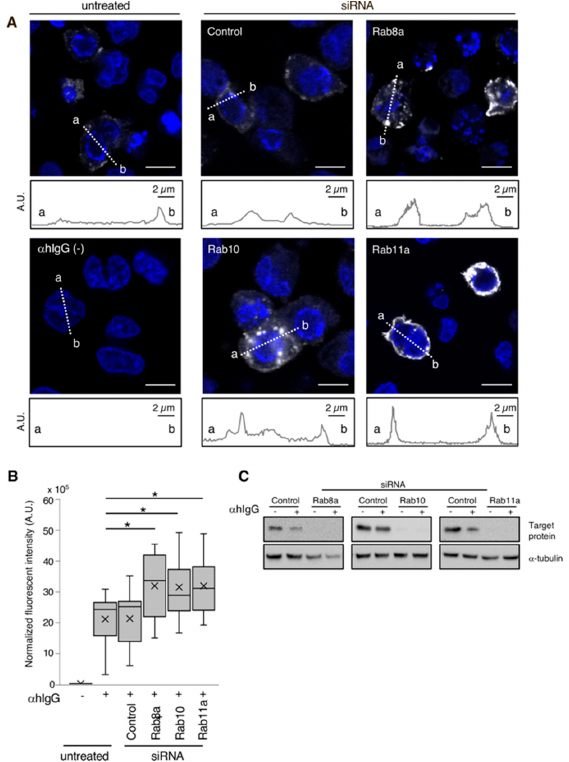
Figure 2. The effect of Rab GTPase downregulation in EBV glycoprotein distribution. Rab8a, Rab10 and Rab11a were downregulated in Akata + cells using siRNAs. After 48 h of treatment with α hIgG for the EBV lytic cycle induction, the distribution of EBV glycoprotein gp350 / 220 was analyzed by immunofluorescence staining. ( A ) Images of gp350 / 220-specific signals (white) are shown. As a control, the images of the siRNA-untreated cells with (top left) or without (bottom left) the lytic cycle induction are shown. Cell nuclei were counterstained with Hoechst 33342 and appear in blue. Plots indicate the fluorescence intensity along each of the corresponding lines. A.U., arbitrary unit. Scale bars: 10 µ m. ( B ) Summary of gp350 / 220 expression. Boxplots represent the fluorescent intensities from gp350 / 220-positive cells in four independent randomly selected fields. Results are representative of three times independent experiments. Average (a cross), median (a line), and standard deviations values are shown. Statistical di ff erences were assessed using Student’s t test and are represented as * p < 0.05 versus respective control. ( C ) Downregulation of Rab proteins was confirmed by Western